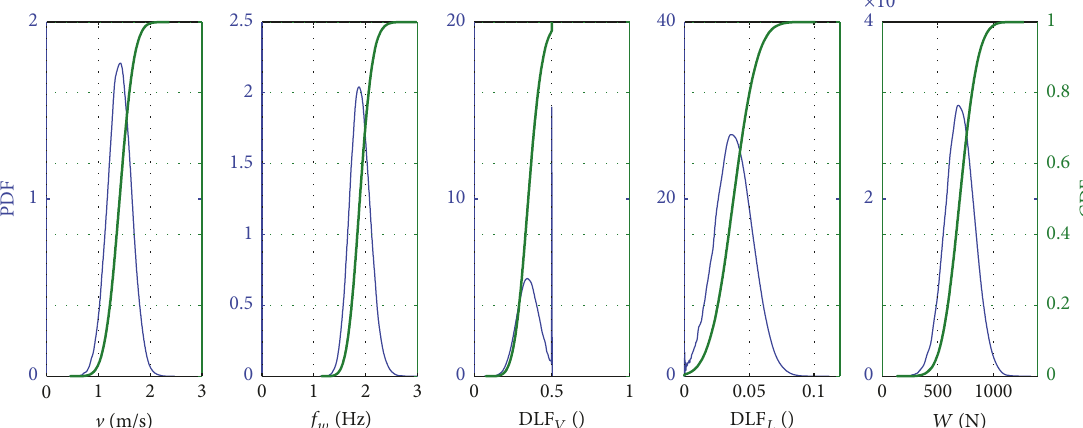
Figure 1: Probability Density Function (PDF, thin line) and Cumulated Distribution Function (CDF, thick line) of the random variables defining the SP: V , 𝑓 𝑤 , DLF 𝑉 , DLF 𝐿 , and 𝑊